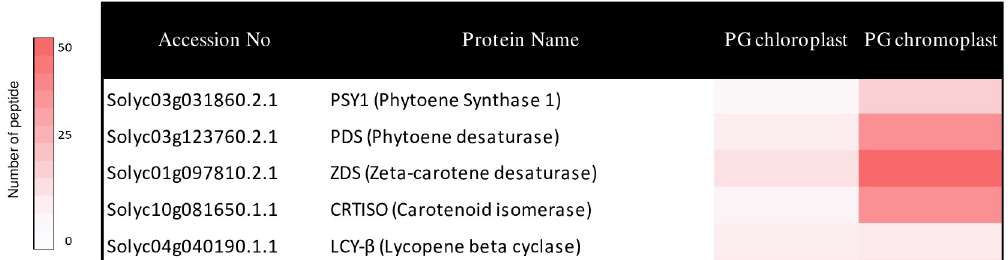
that underpin lycopene biosynthetic activity in the chromoplast and during the chloroplast-to- chromoplast transition (Fig 3). Peptide counts for LYCB were similar in both plastid types, suggesting a constant activity of this enzyme in PG during chloroplast to chromoplast conver- sion (Fig 3). Heatmaps also showed reduced presence of FBNs and ABC1Ks in the chromo- plast PG compared with chloroplast PG (S1 Fig).